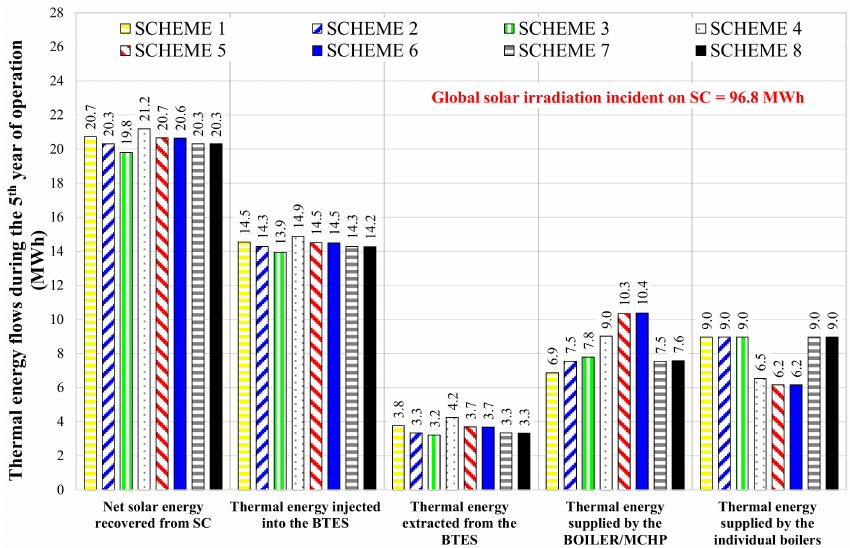
Figure 10. Thermal energy flows during the fifth simulation year as a function of the system scheme.